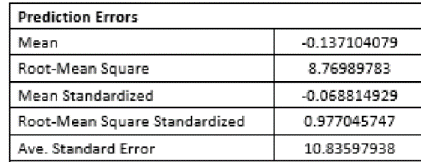
Table 4: Zonation and their corresponding Moran’s I result